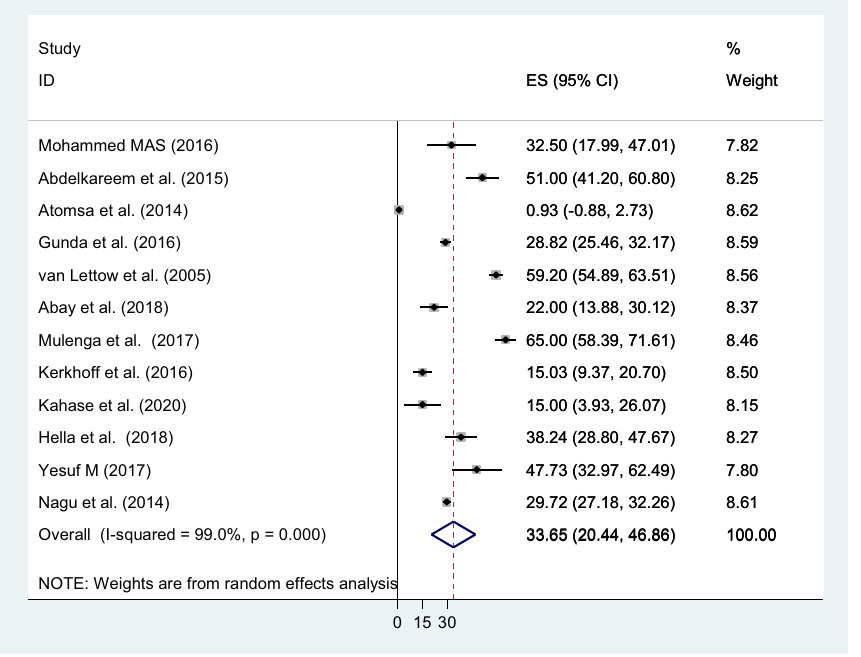
Figure 3. The pooled prevalence of mild anemia in patients with TB.